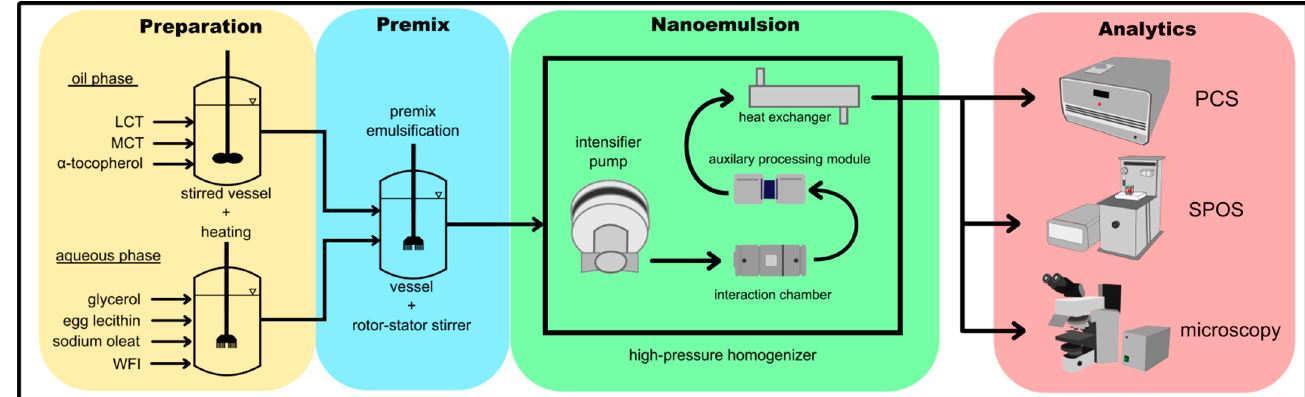
Figure 2. Manufacturing process for parenteral fat emulsions and subsequent analytics. Production starts with the preparation of the aqueous and oil phases, followed by coarse and then fine emul- sification in the interaction chamber of a high-pressure homogenizer with an auxiliary processing module and heat exchanger. The product is then characterized by photon correlation spectroscopy (PCS), single-particle optical sensing (SPOS), and microscopy (droplet